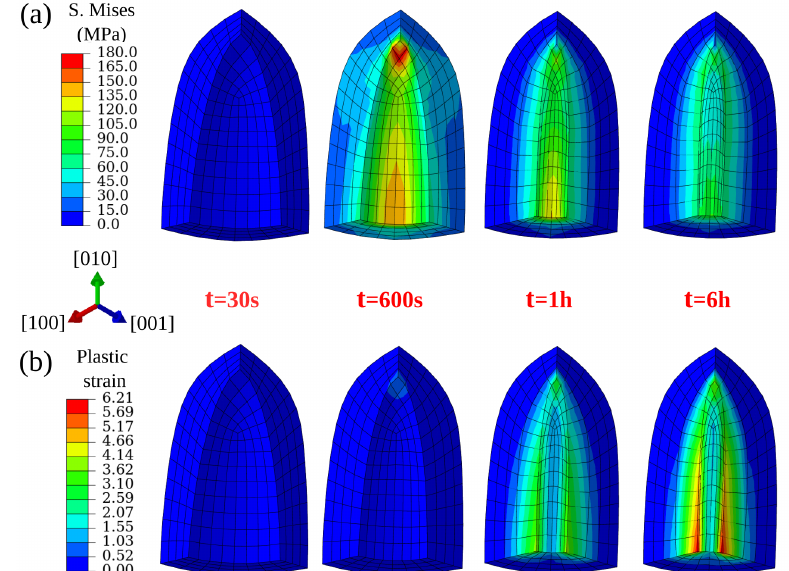
Figure 9. Von Mises stress ( a ) and plastic strain ( b ) evolution around an ellipsoidal void (zoomed area) with increasing simulation time under 100 MPa isostatic pressure at 1561